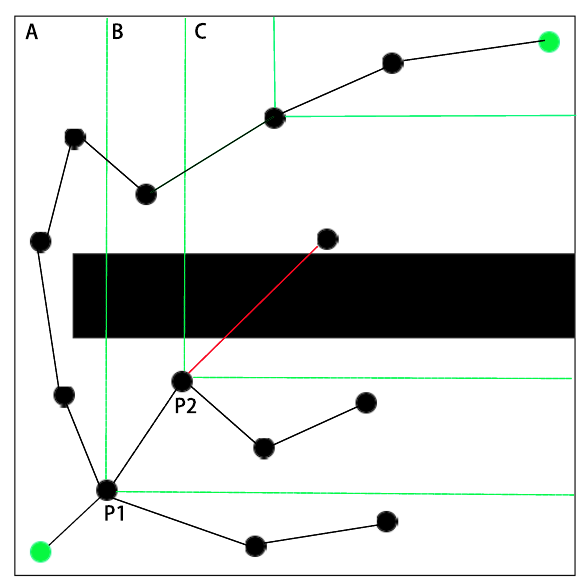
Figure 2. The sampling space A is reduced to B through P1 and then reduced to C through P2. The expansion fails in C. The first fall back sampling and then forward sampling.